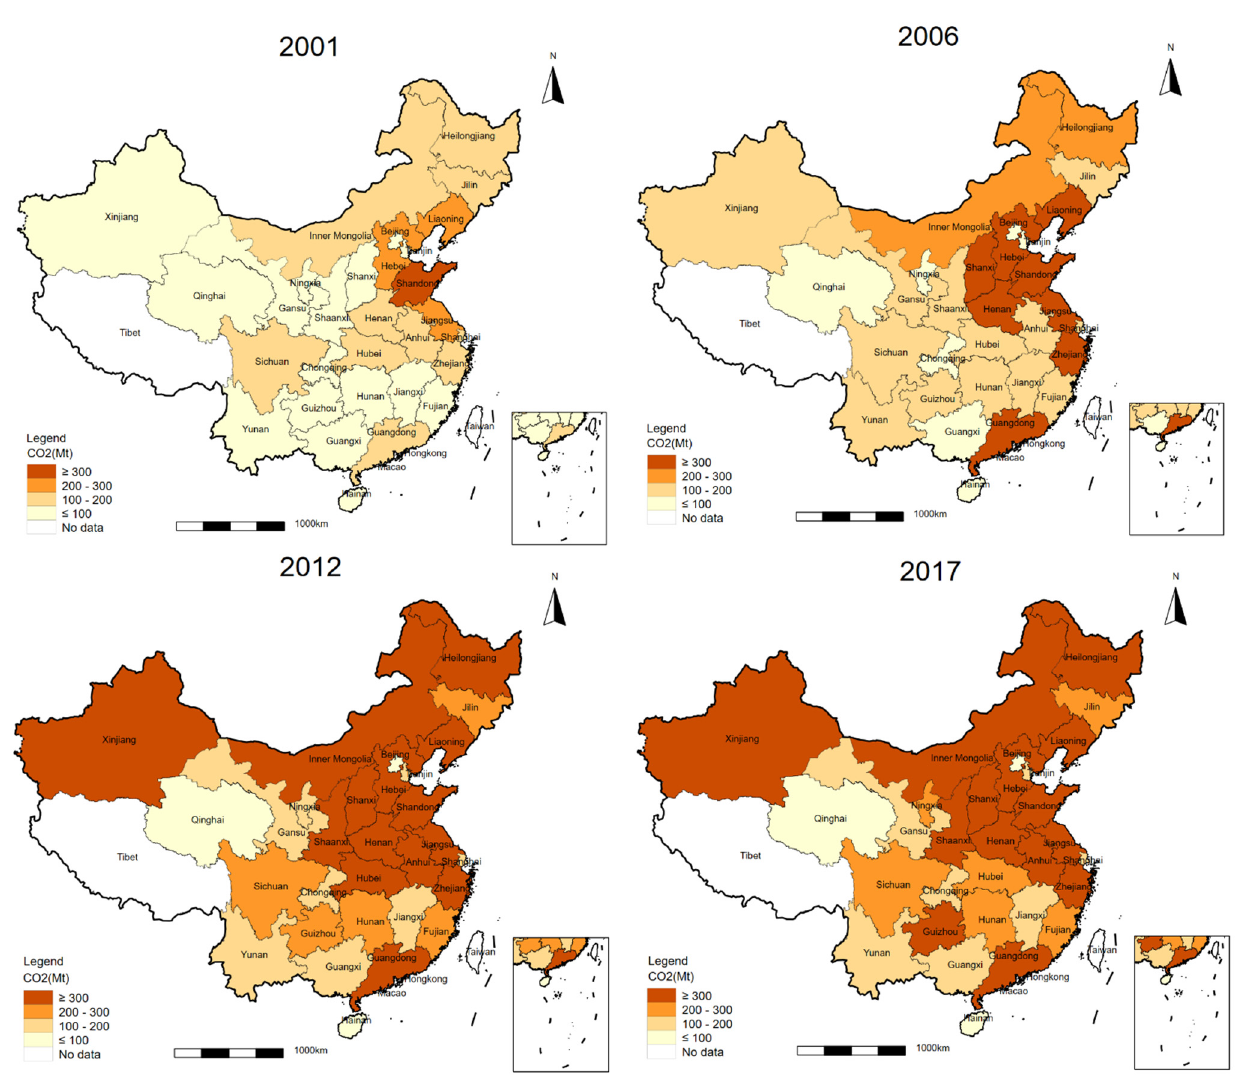
Figure 3. CO 2 emissions in China across 30 provinces.